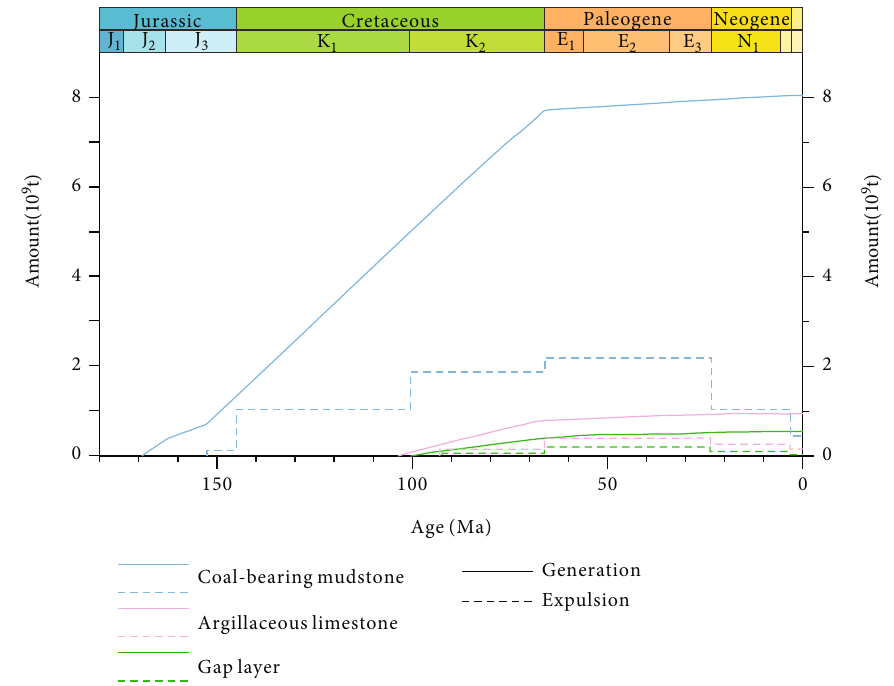
Figure 9: Hydrocarbon generation and expulsion curves of the source rocks in the